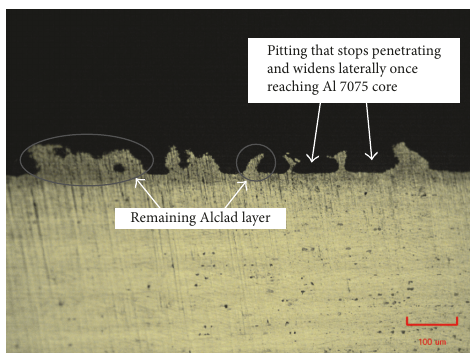
Figure 3: Clad panel and region after corrosion, 100x magnification and 100-micron bar.